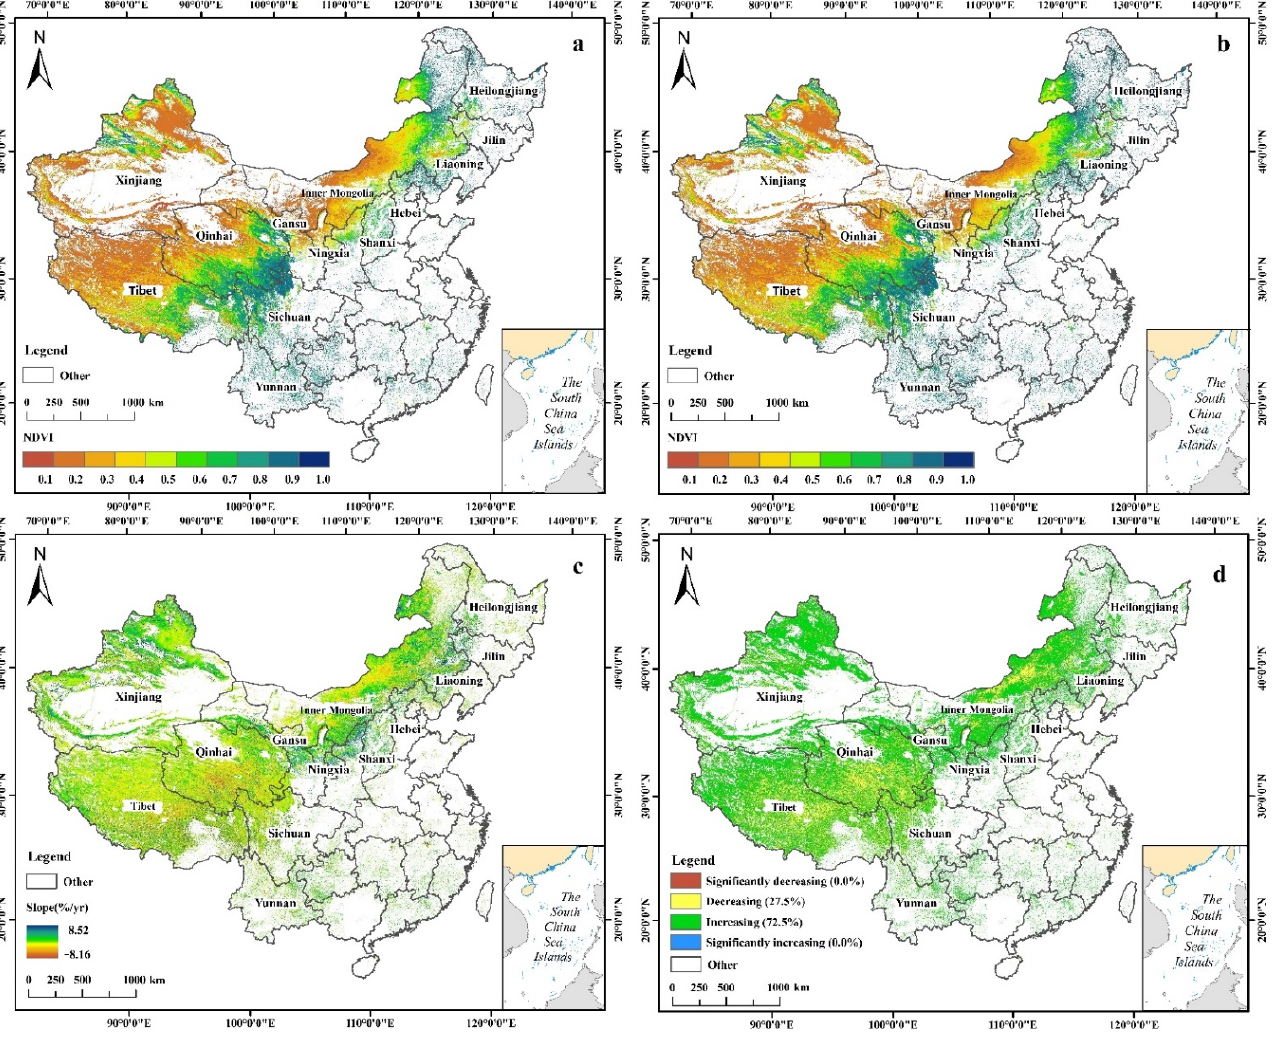
Figure 2. The spatial distribution pattern and the changing trend of the grassland NDVI in China before (2004–2010) and after (2011–2017) the implementation of the SISGC. The average grassland NDVI before the SISGC implementation ( a ); the average after the SISGC implementation ( b ); trend changes between 2004–2017 ( c ); trend change grading ( d ).